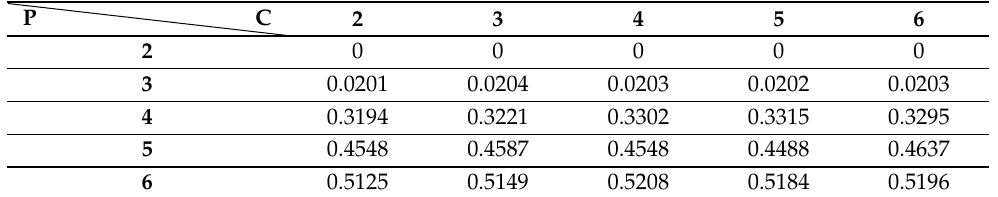
Table 5. Performance index of AGM that created context evenly.